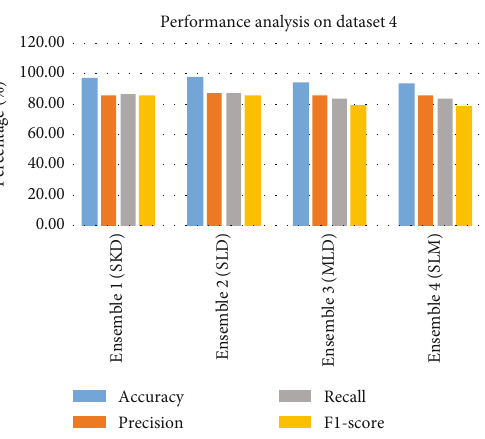
Figure 9: Performance analysis on dataset 4.